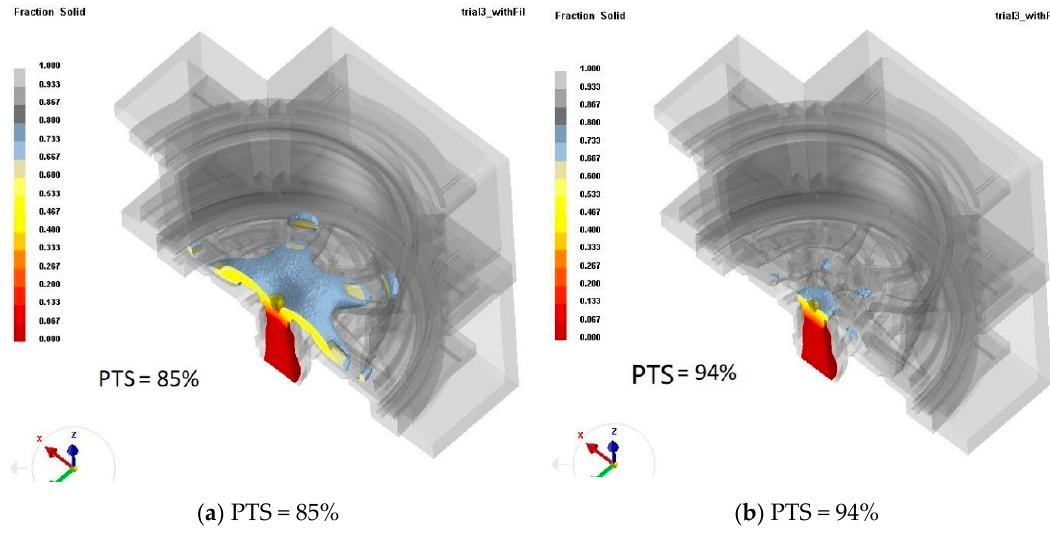
Figure 18. Solidification path for the non-production process condition.